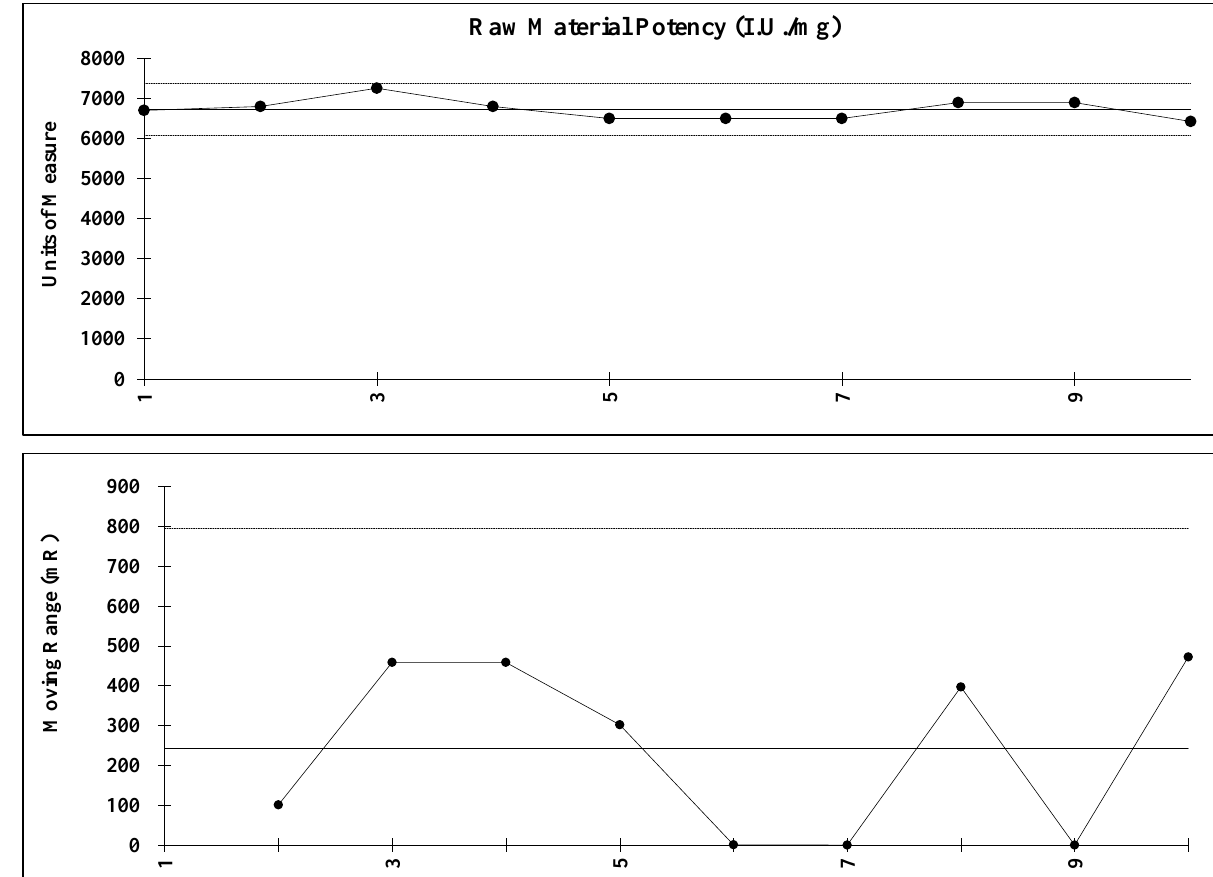
Figure 7. I-MR (XmR) control charts for potency determinations of Nystatin in the pharmaceutical preparations and as raw